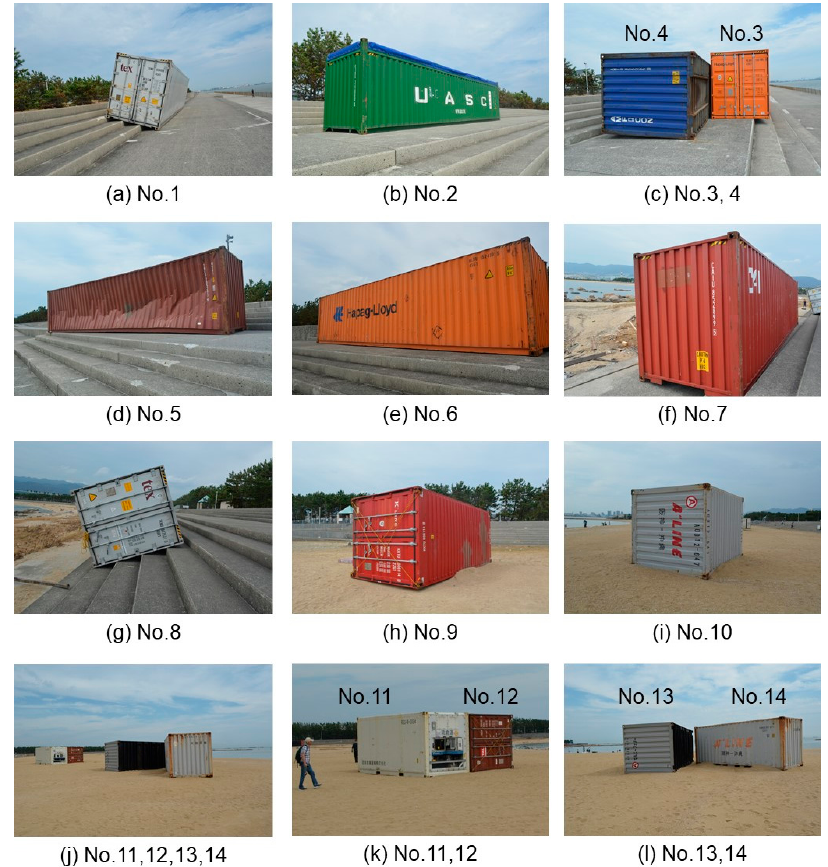
Figure 10. Photographs of the displaced containers. The numbers correspond to the identification numbers of each container shown in Table 3.